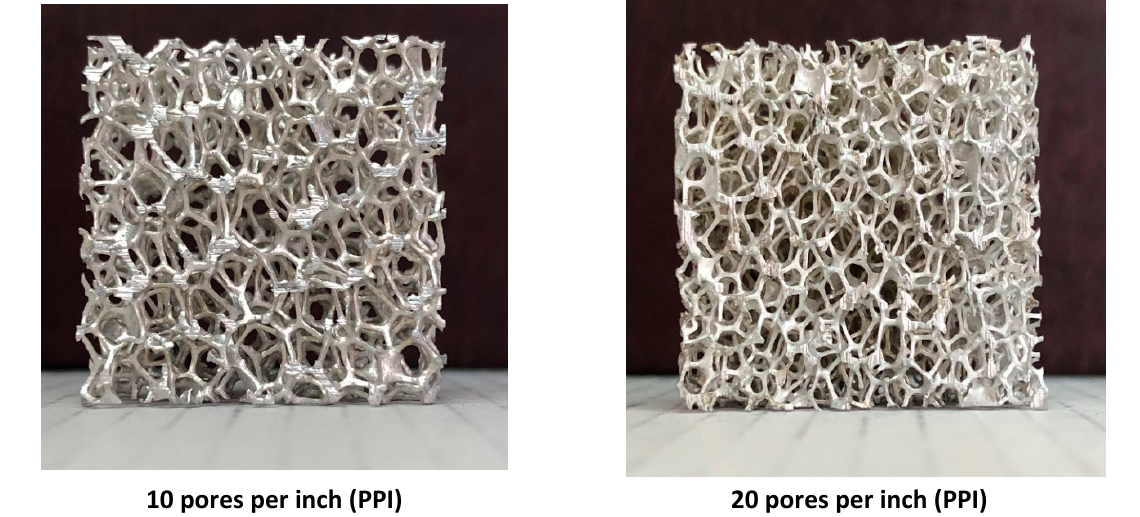
10 pores per inch (PPI) 20 pores per inch (PPI) Figure 7. 25.4 mm × 25.4 mm × 12.7 mm samples of 8% open ‐ cell aluminium foams with different pore sizes. Figure 7. 25.4 mm × 25.4 mm × 12.7 mm samples of 8% open-cell aluminium foams with different pore